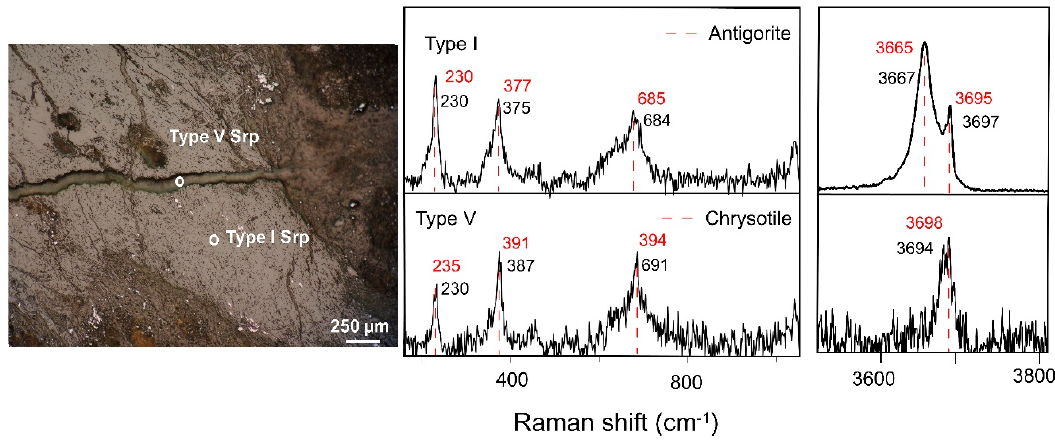
Figure 9 . Raman signatures of type I and type V vein serpentines identified in the saprock developed above clinopyroxenite bedrock (PG1500 core). Red dashed lines indicate the Raman bands from previous work [21,39].